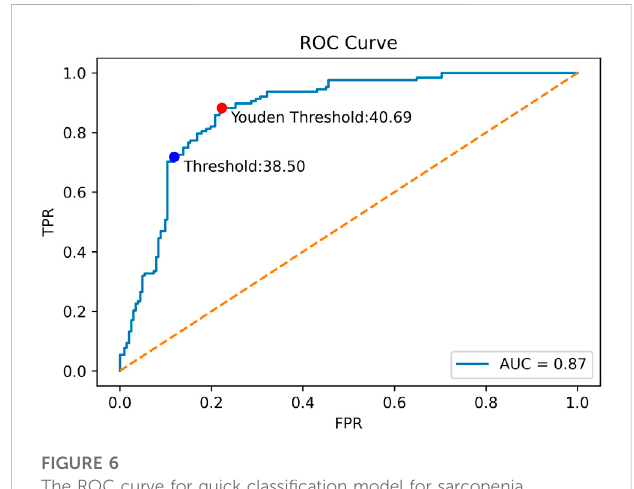
FIGURE 6 The ROC curve for quick classi fi cation model for sarcopenia